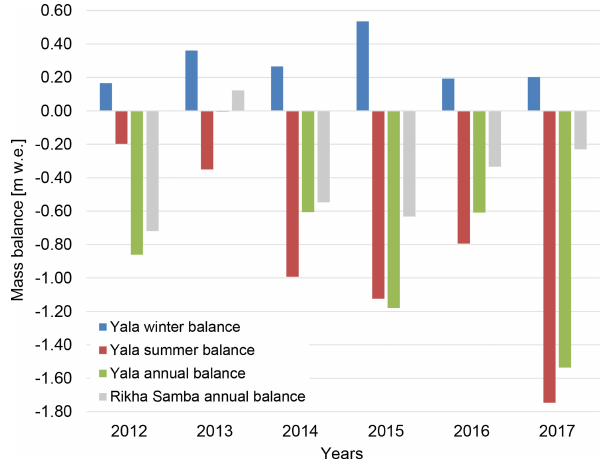
Figure 4. Winter, summer and annual mass balance of Yala Glacier and annual balance of Rikha Samba Glacier, calculated based on the respective gradients. In the mass-balance years 2011/2012 and 2014/2015, the sum of winter and summer balances differs signifi- cantly from the annual balances, likely due to a lack of data at higher elevations. The summer balance from 2011/2012 and winter bal- ance from 2014/2015 have not been reported to the